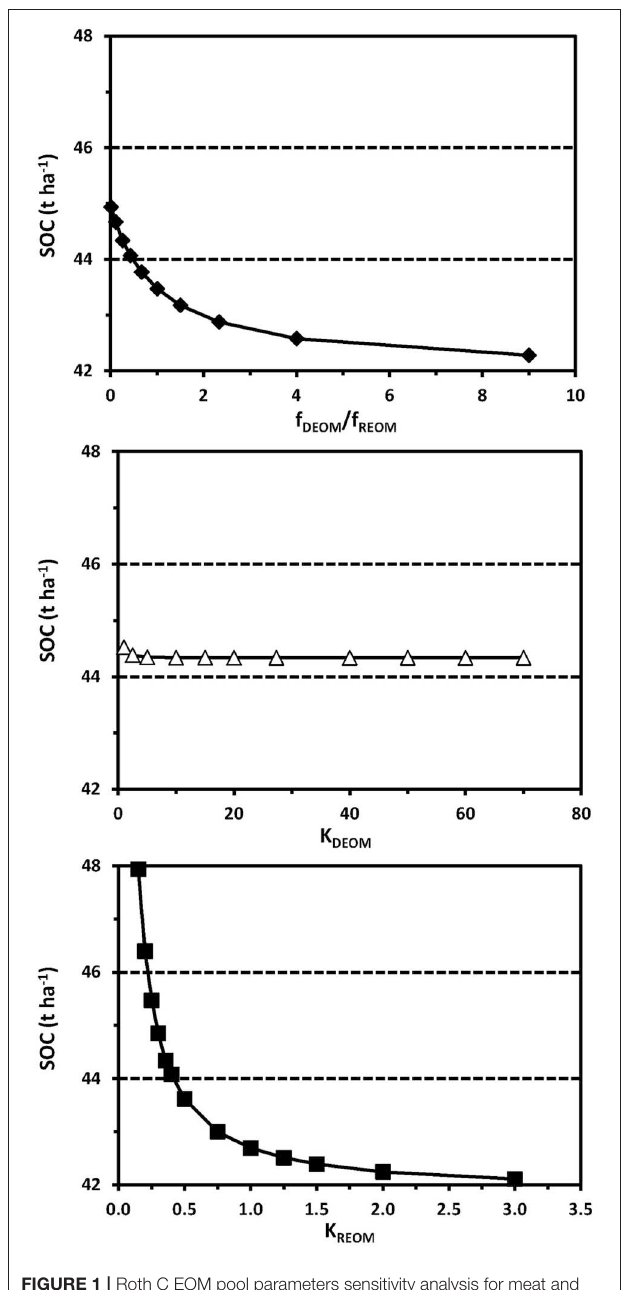
FIGURE 1 | Roth C EOM pool parameters sensitivity analysis for meat and bone meal amended